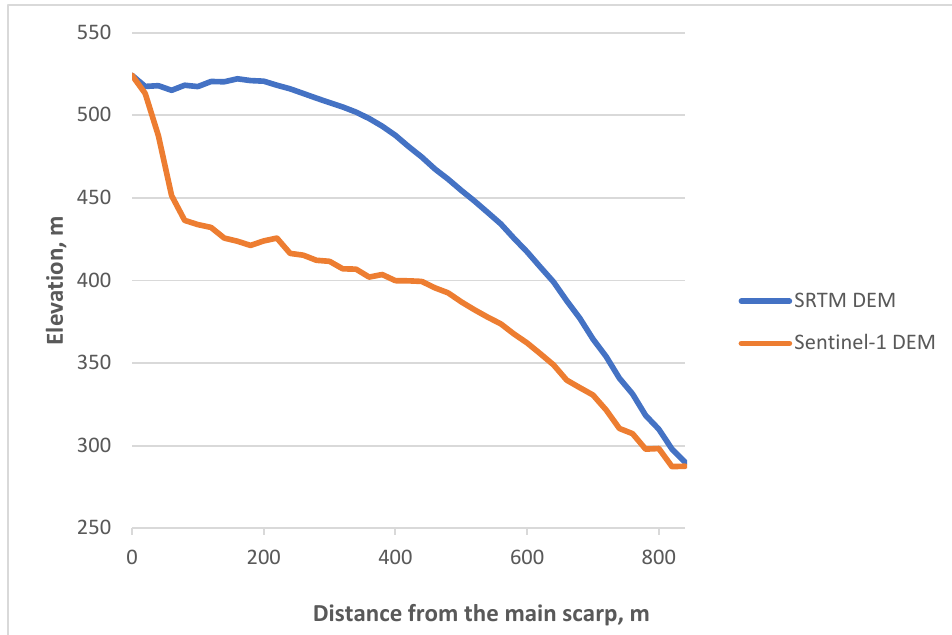
Figure 11. Height profiles before (blue line) and after (orange line) the landslide.